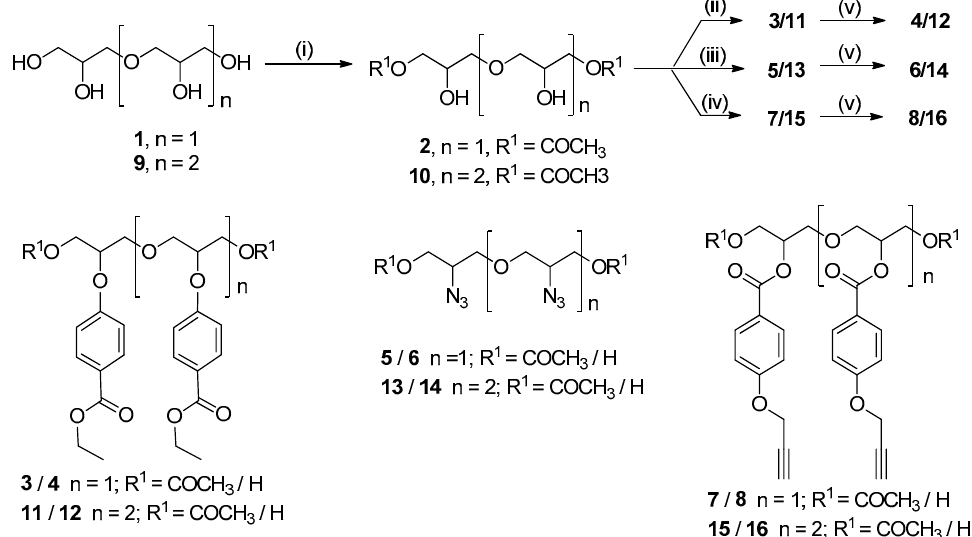
Scheme 1. Synthesis of diglycerol/triglycerol based building blocks. Reagents and Conditions : ( i )